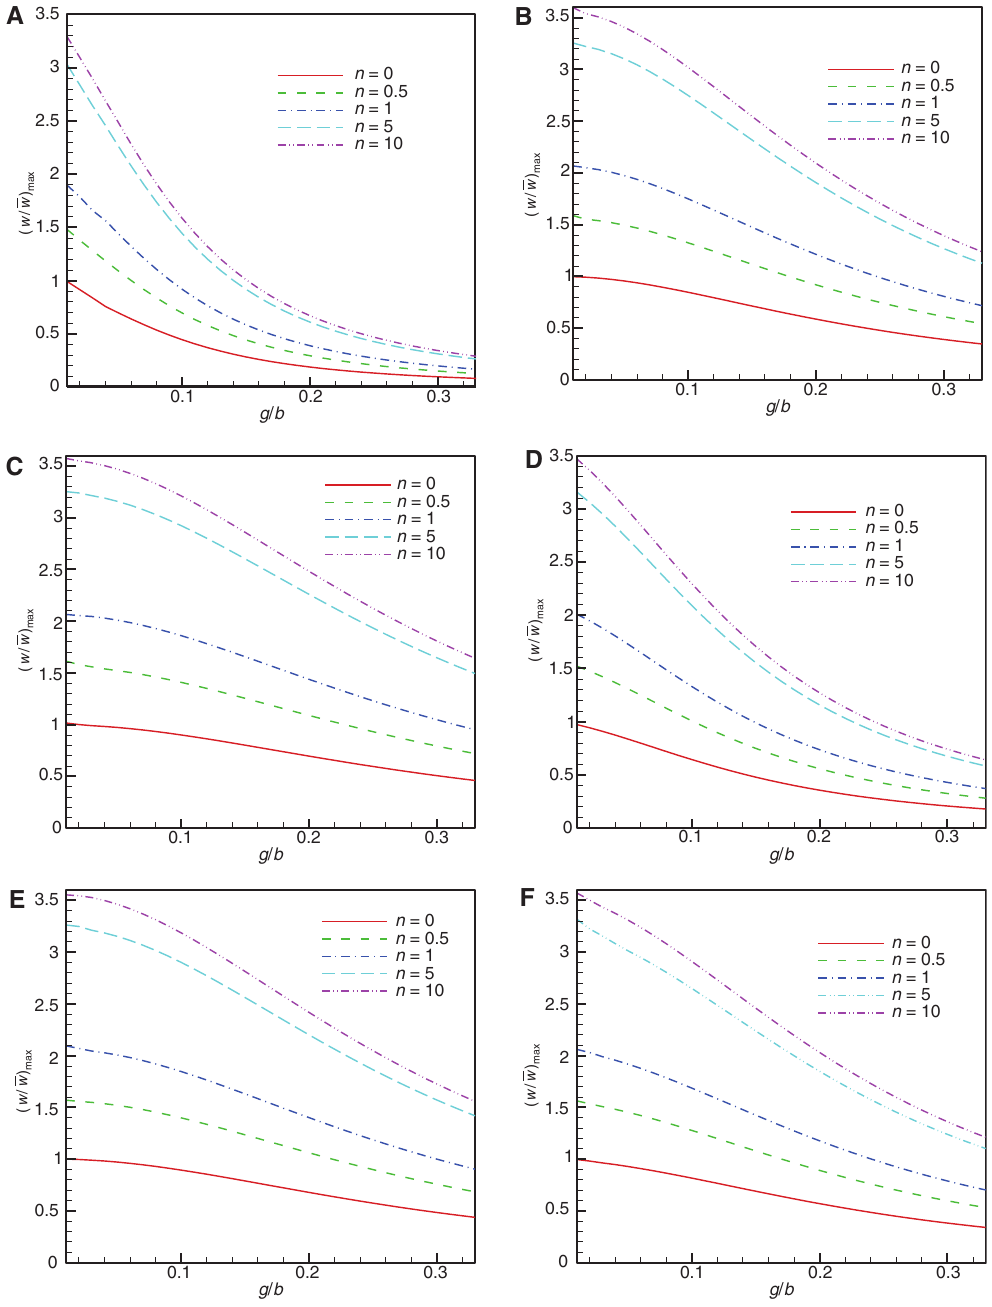
Figure 3: Non-dimensional deflection vs. variation of non-dimensional length scale parameter. (A) SCSC micro-plate, (B) SSSS micro-plate, (C) SFSF micro-plate, (D) SSSC micro-plate, (E) SSSF micro-plate, and (F) SFSC